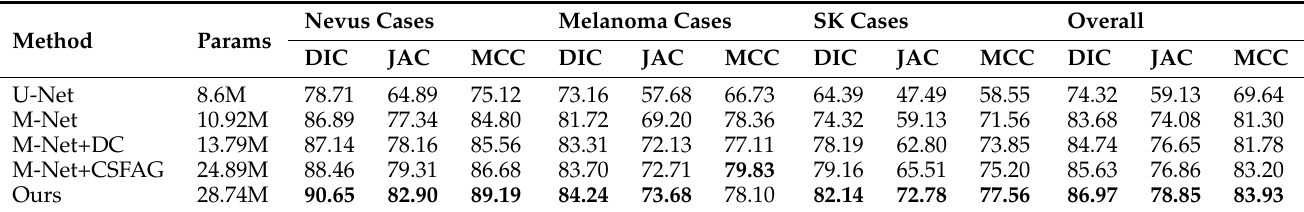
Table 4. On the ISIC-2017 data set, performance comparison of U-Net, M-Net, M-Net+DC (Dense Convolutions), M- Net+CSFAG and CSAG and DCCNet (ours) in Jaccard coefficient, Dice coefficient and Matthew correlation coefficient. Bold data indicates that the value is the maximum value in this